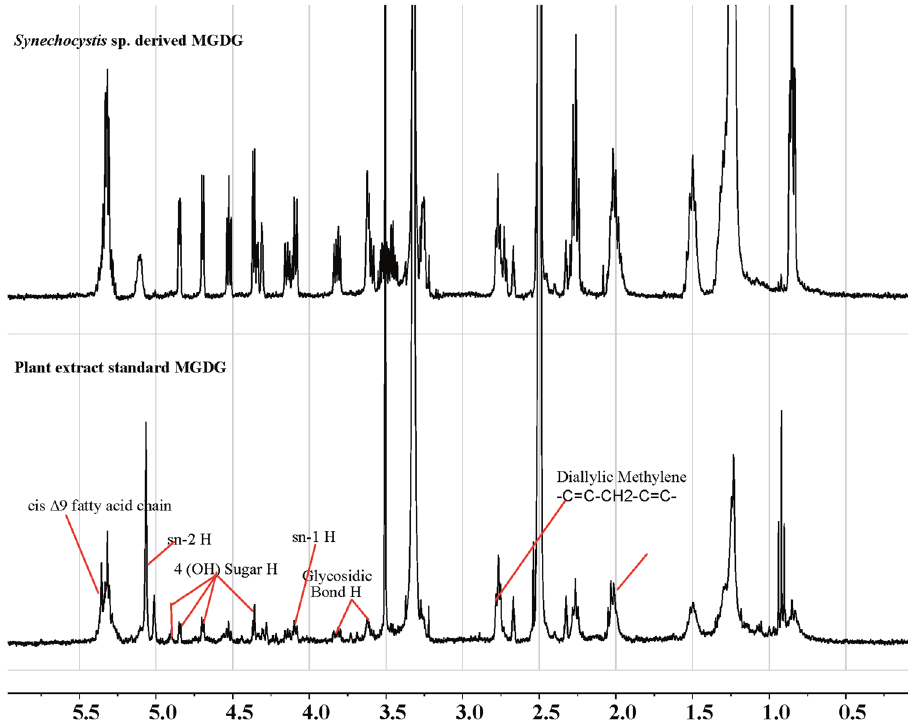
Figure 4. Structural identification of MGDG extracted from Synechocystis sp. PCC 6803. 1 H NMR analysis of MGDG extracted from the Synechocystis sp. shows that the fraction molecule (upper panel) contains all the major structural H components δ 2.8 (diallylic methylene), δ 3.6 and 3.8 (Glycosidic H moiety), δ 4.18 (sn-1 H), δ 5.15 (sn-2 H), δ 5.25 cis ∆9 moieties present in the standard MGDG molecule (lower panel). The cyanobacterial NMR spectra are identical to the NMR spectra of the MGDG standard confirming the purity of the extracted MGDG molecule.